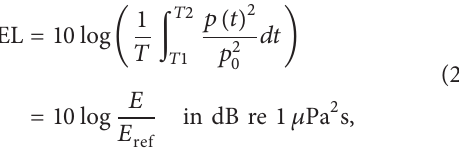
), and distance from – 𝑝